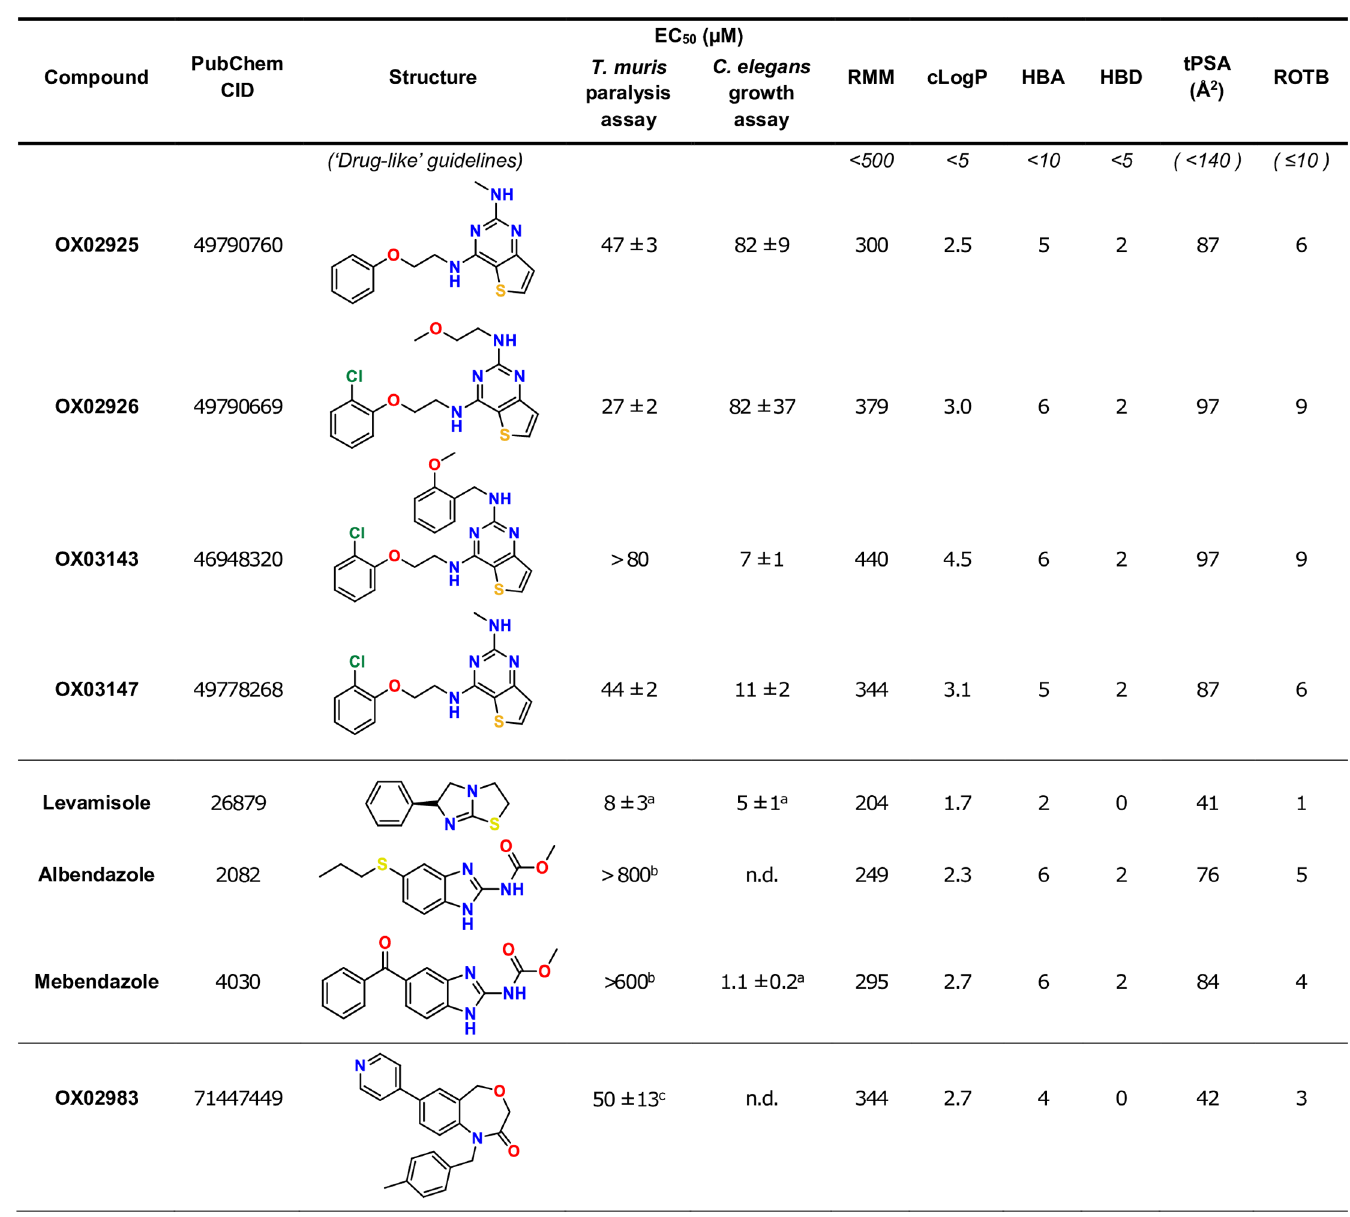
Fig 4. Properties and activities of resynthesized diaminothienopyrimidines, and other anthelmintics. RMM: relative molecule mass. HBA: number of hydrogen bond acceptors. HBD: number of hydrogen bond donors. tPSA: topological polar surface area, calculated using DataWarrior [20]. ROTB: number of rotatable bonds. a Data from [15]. b Data from [21]. c Data from